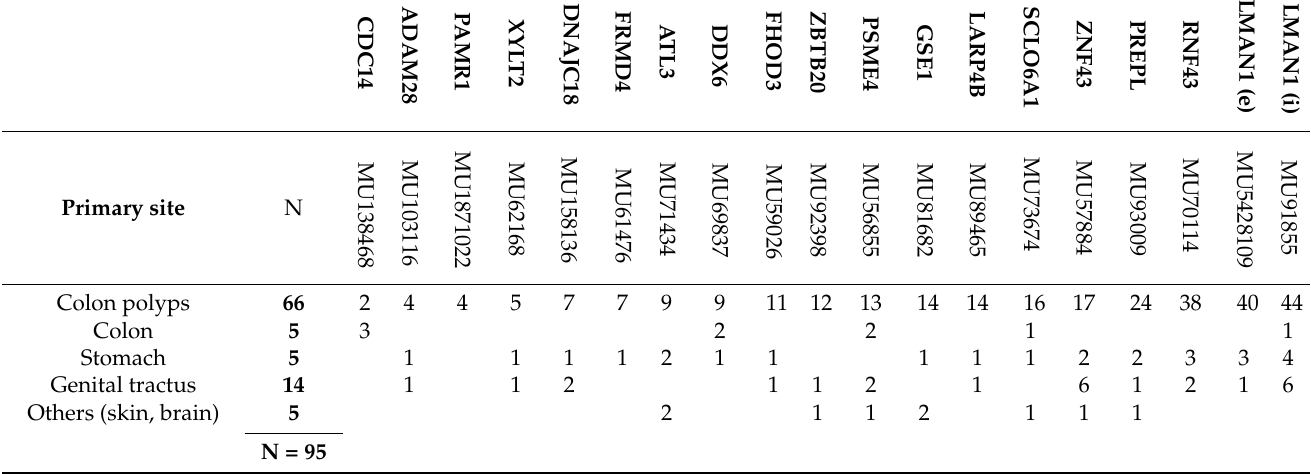
Table 2. Frequent PPT mutations in and across various MSI cancers. Mutations occurring at or very near RNA-binding sites of splice proteins involved in splicing were retrieved from the TCGA/ICGC database. The table shows the names of the genes, their associated mutation numbers, and the numbers of occurrence in the groups of cancers. LMAN1 (Lectin, mannose binding 1) (e) is an exonic mutation, while LMAN1(Lectin, mannose binding 1) (i) is an intronic mutation.